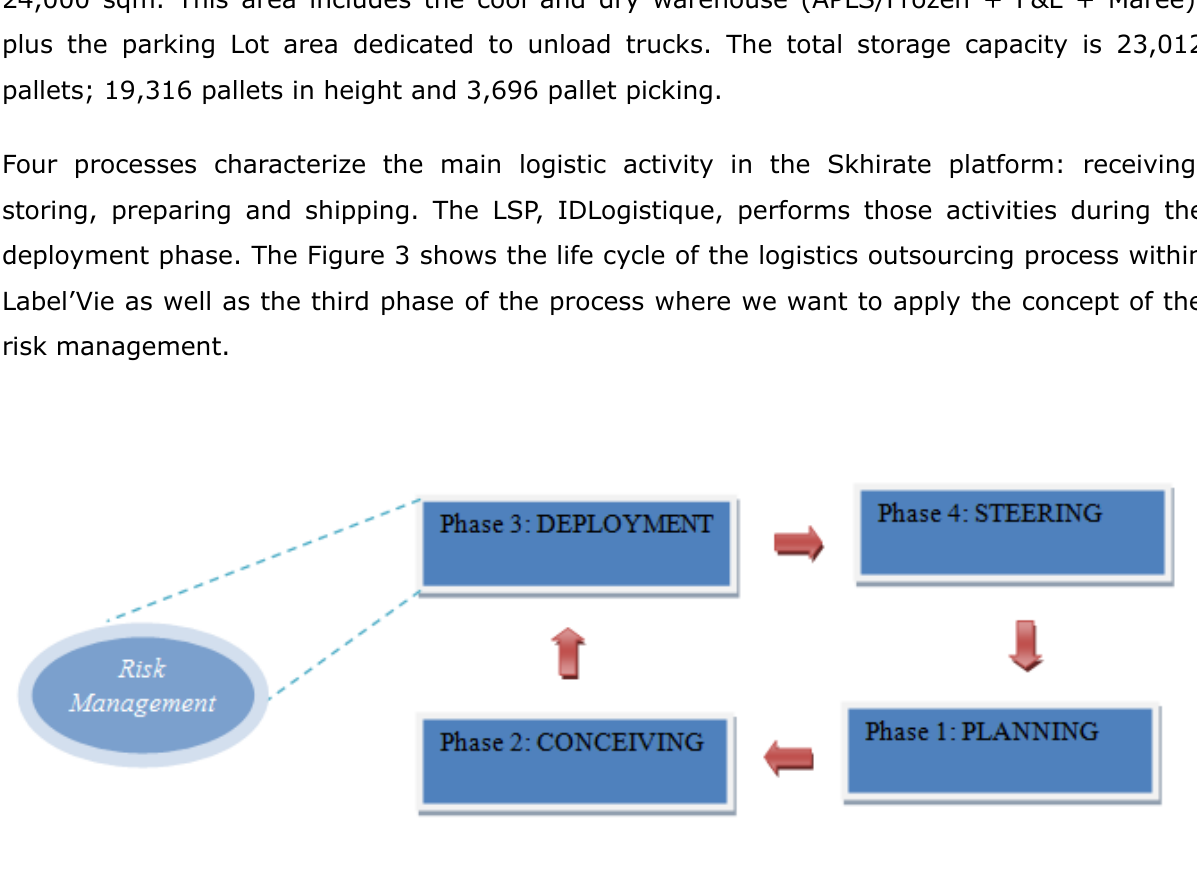
Figure 3. The Life cycle of the logistics outsourcing within